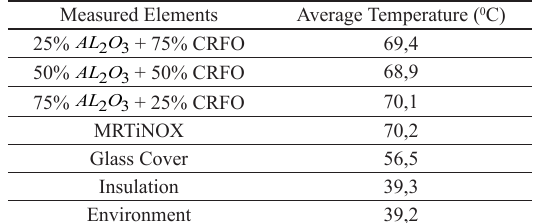
Table 2. Average